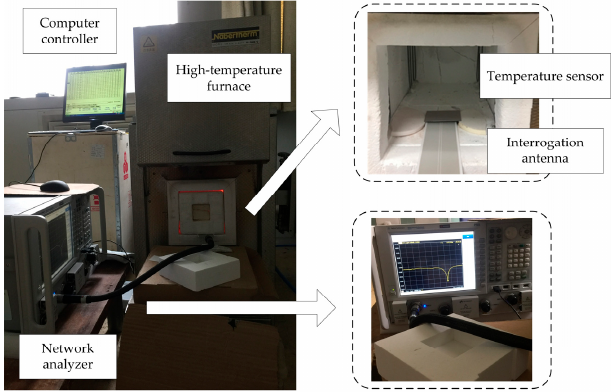
Figure 9. Temperature testing setup.